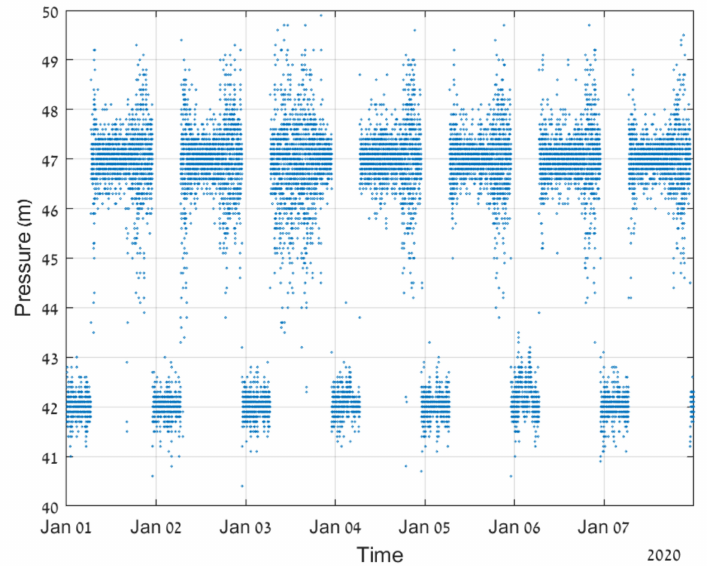
Figure 5. Pumping station discharge pressure.